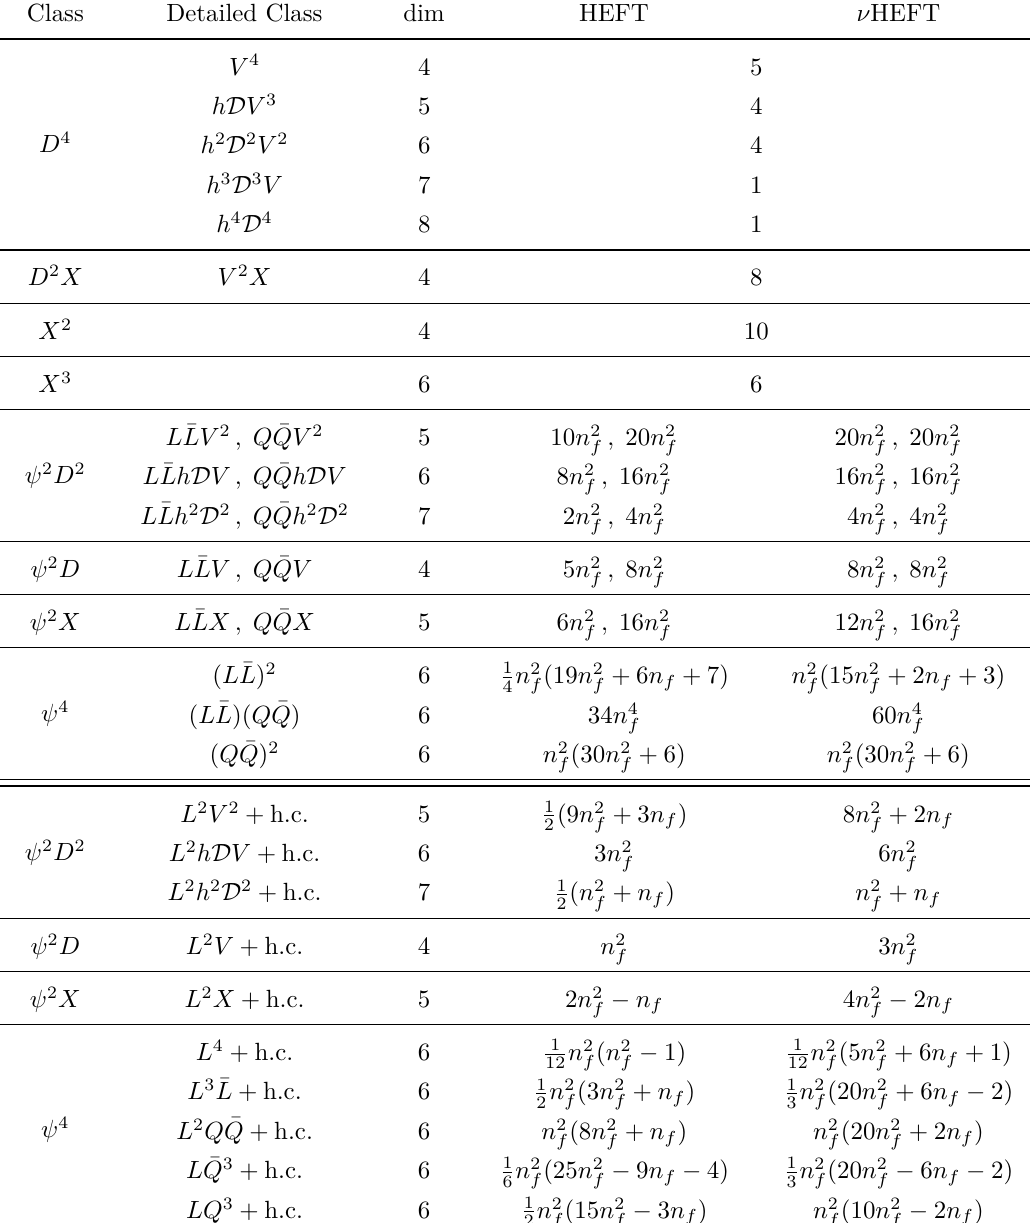
Table 4 . Detailed breakdown of the eight classes of operators that are relevant for “NLO” ( ν )HEFT. The upper section contains operators preserving both the Baryon number B and the Lepton number L , while the lower section contains operators breaking B and/or L